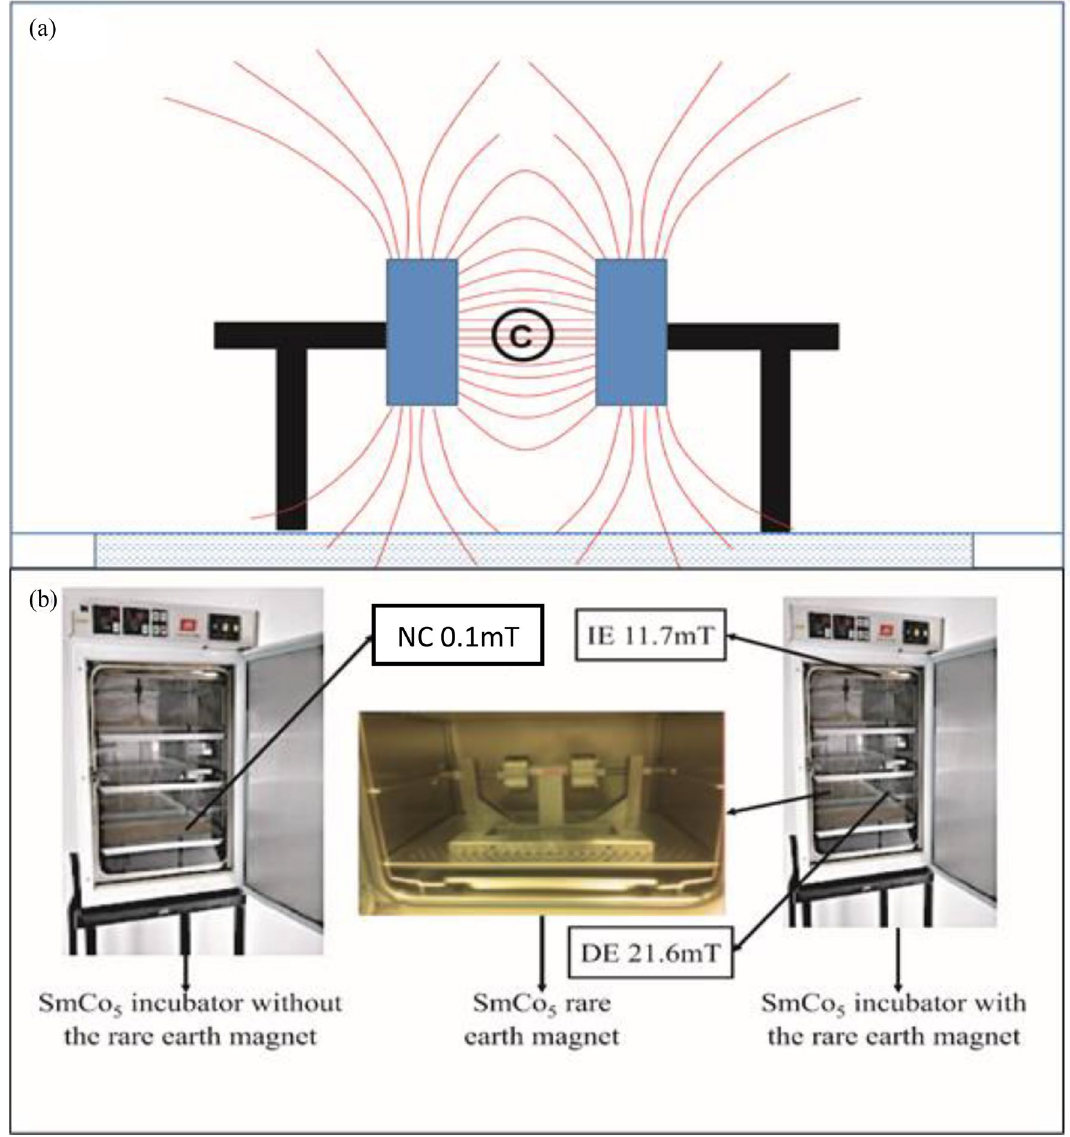
Figure 6. ( a ) The schematic diagram above shows the distribution of MF lines between a pair of rare earth magnet. The centre region between the two magnet cylinders © is where the MF most uniform and intense. ( b ) Setup showing how cells in the direct exposed (DE) and indirect exposed (IE) groups were placed at different locations in the incubator. The DE group and IE group are in the same incubator and the negative control (NC) group in a different